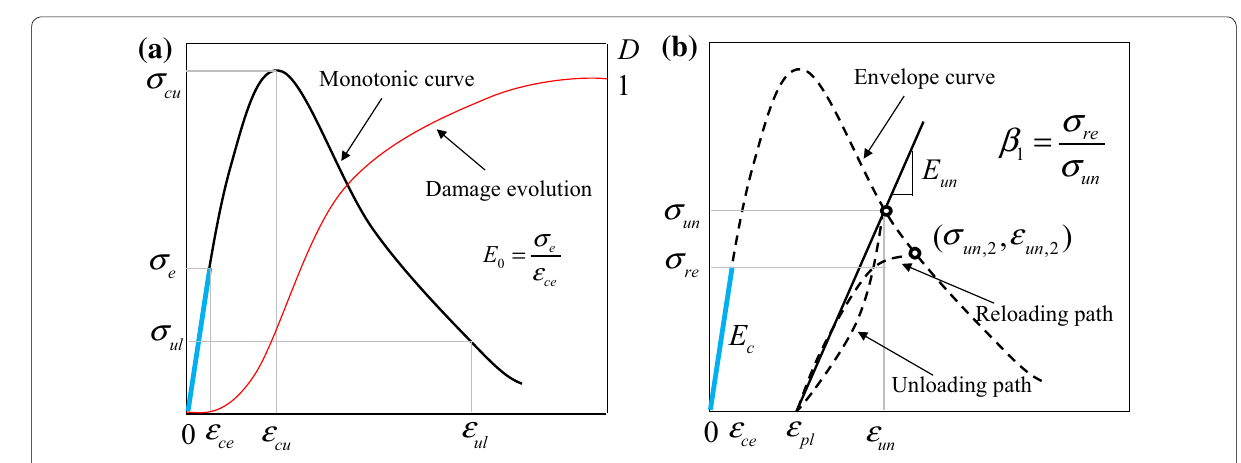
Fig. 17 Stress–strain model for PFRC. a Monotonic loading; b Cyclic